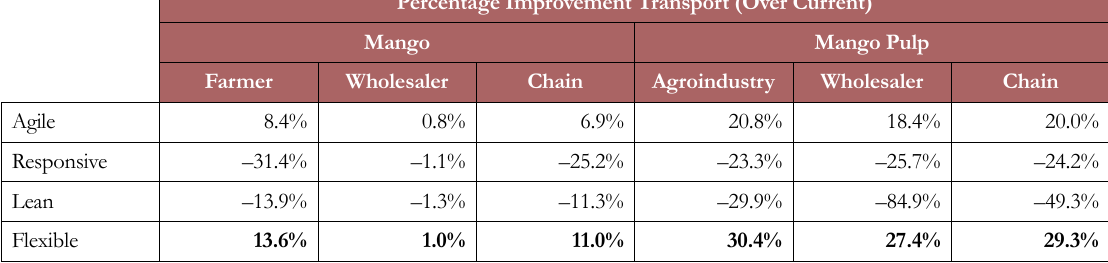
Table 8a. Percentage Change transport for mango